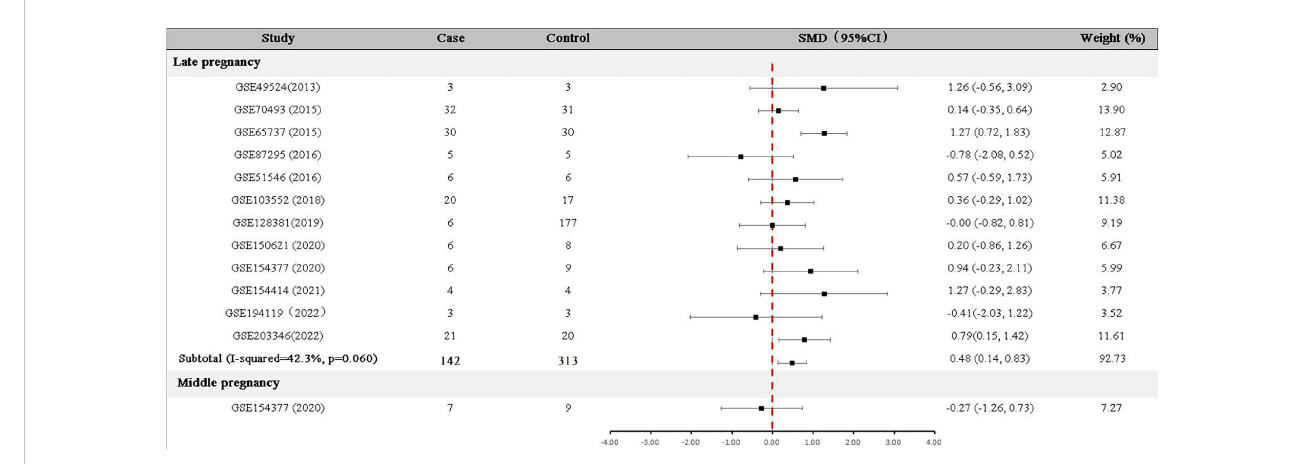
FIGURE 2 Difference of GDF-15 mRNA expression between GDM patients and non-GDM pregnant